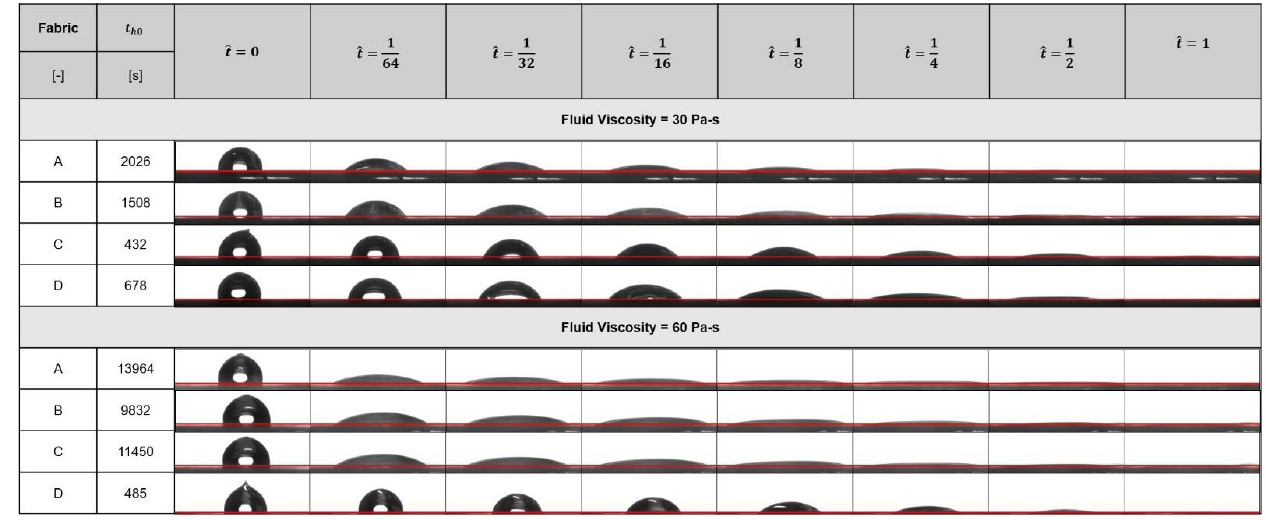
Figure 7. Time lapse of side view for all combinations of fluid viscosity and fabric types. Each snapshot is at a fraction of the time to full sorption for that test. Red line corresponds to the baseline from which height is measured, equal to the height of the droplet at 𝑡 = 𝑡 ℎ0 (ℎ = 0).